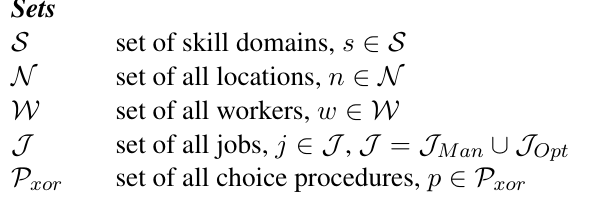
Table 1. Sets, parameters, and decision